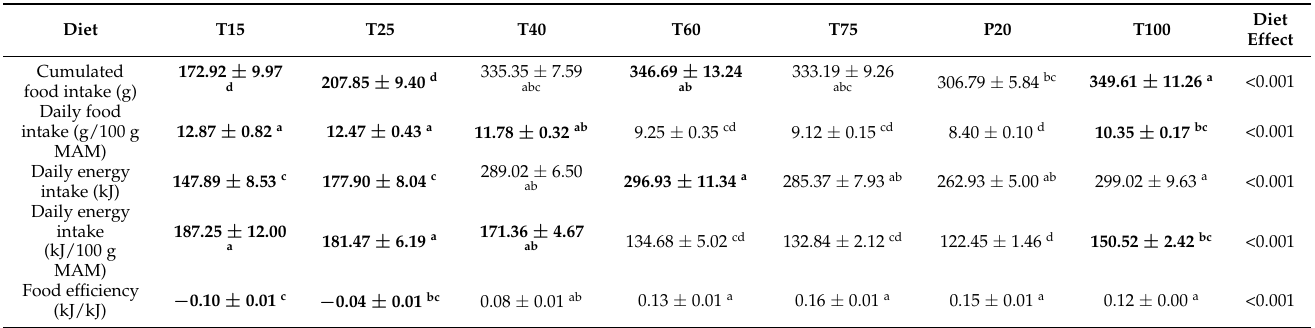
Table 2. Absolute and relative values of energy and food intake for threonine diets.